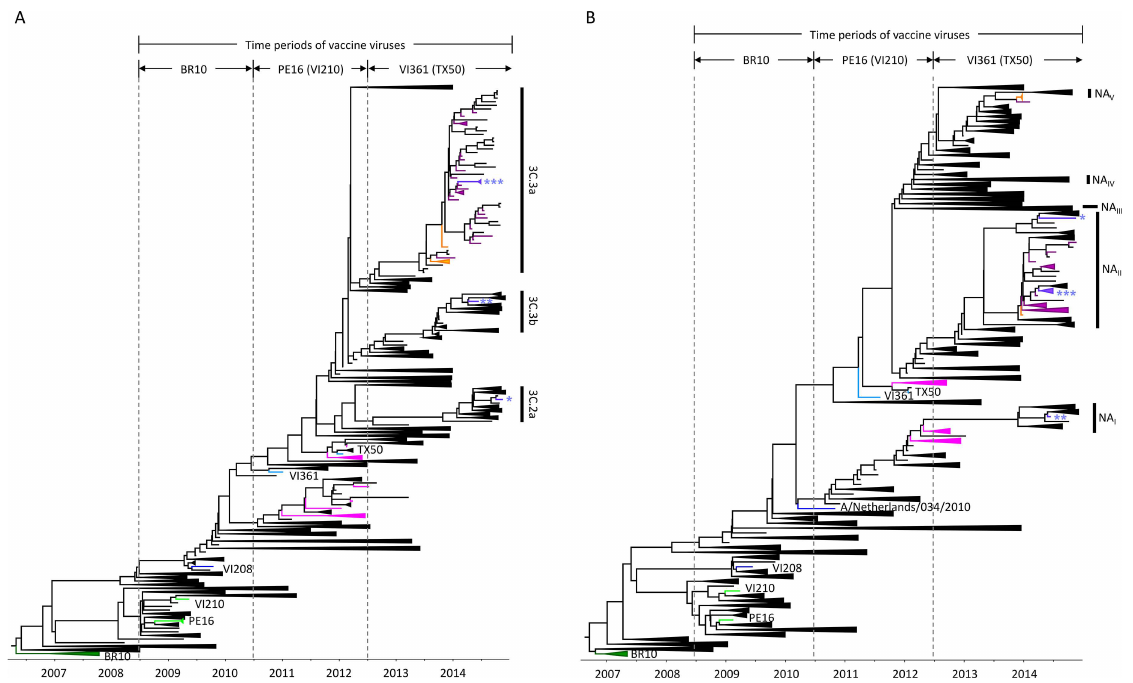
Fig 3. Clustering patterns of the HA and NA genes between the vaccine and circulating H3N2 strains during the 2008/09- 2013/14seasons. To comparethe phylogenetic clusteringpatterns of the HA and NA genes betweenthe vaccine and circulating H3N2strains, the evolutionaryrelationships of the HA and NA genes were reconstructed using the geneticsequencesof the 2008/ 09-2013/14 seasons. The vaccine virus tips (BR10, dark green; PE16 and VI210, light green; and VI361 and TX50, sky blue) and the 2011/12-2013/14 KUMC sequencesare indicatedwith different colors: for 2011/12, pink; for 2012/13, orange; and for 2013/14, purple. The tips of clade-defining sequenceswere colored blue (VI210 and A/Netherlands/034/2010). For the three HA clades, each representative sequencewas indicatedwith the different numberof an asterisk ( * , clade 3C.2a, A/Stockholm/29/2014; ** , clade 3C.3b, A/Newcastle/22/2014; and *** , clade 3C.3a, A/South Australia/55/2014), and the same asterisk annotationwas used for the NA of each corresponding strain. The five differentiated NA clades are indicatedwith NA I , NA II , NA III , NA IV , and NA V ,